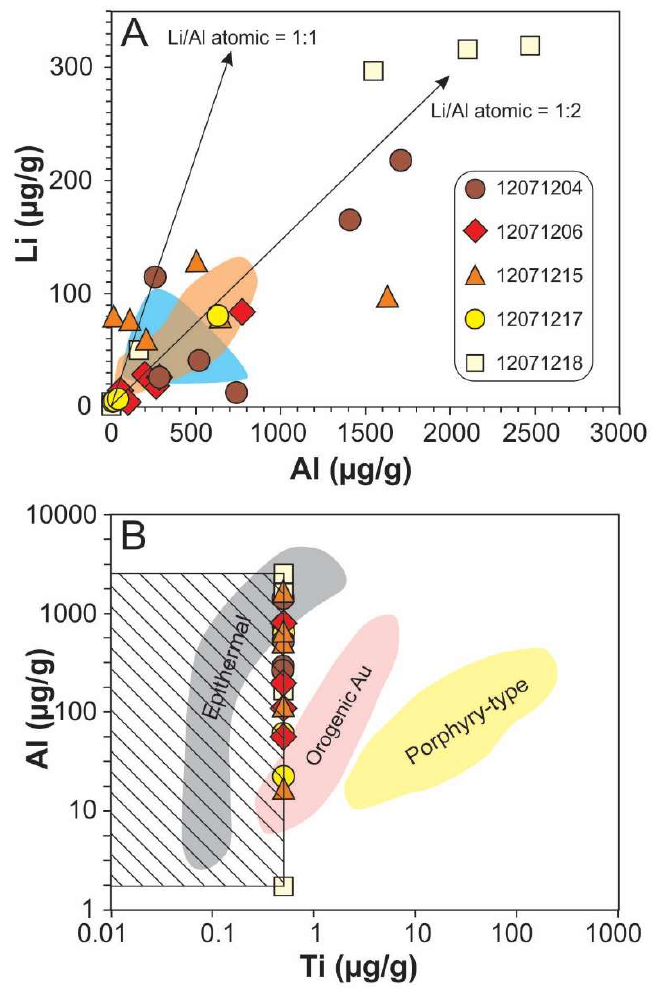
Figure 9. Trace element concentrations of quartz crystals forming the matrix of the Berglia-Glassberget. Concentrations were determined with LA-ICP-MS. ( A ) Al versus Li plot. Arrows indicate atomic ratios 1:1 and 2:1. The orange-shaded area corresponds to values of quartz from the Li-rich Tres Arroyos granite-pegmatite suite (Spain) [61] and the blue-shaded area those from the Li-bearing Land’s End pluton in Cornwall (UK) [60]. ( B ) Logarithmic Ti versus Al plot of quartz of the Berglia-Glassberget breccia compared with data from Rusk [58] including c. 30 porphyry-type (Cu-Mo-Au) deposits, orogenic Au deposits, and epithermal deposits. The hatched field corresponds to the Berglia-Glassberget dataset because the Ti contents are below the detection limit of 0.5 µg/g. For symbol explanation see Figure 9A. Table 4. Concentrations of trace elements (µg/g) of quartz crystals determined by LA-ICP-MS. CL Intensity Li Mn Ge Sr Al P Ca